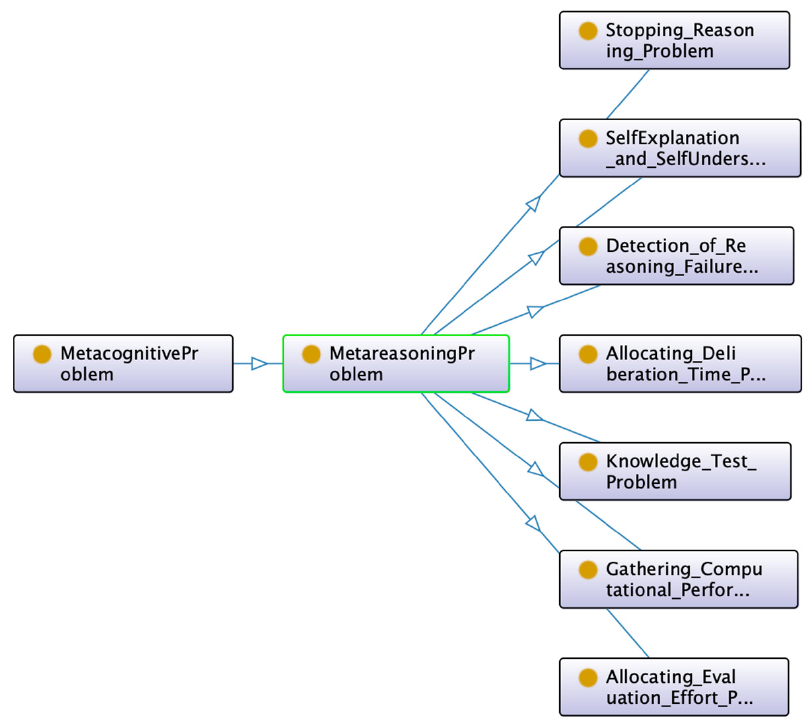
Figure 5. Subontology hierarchy .